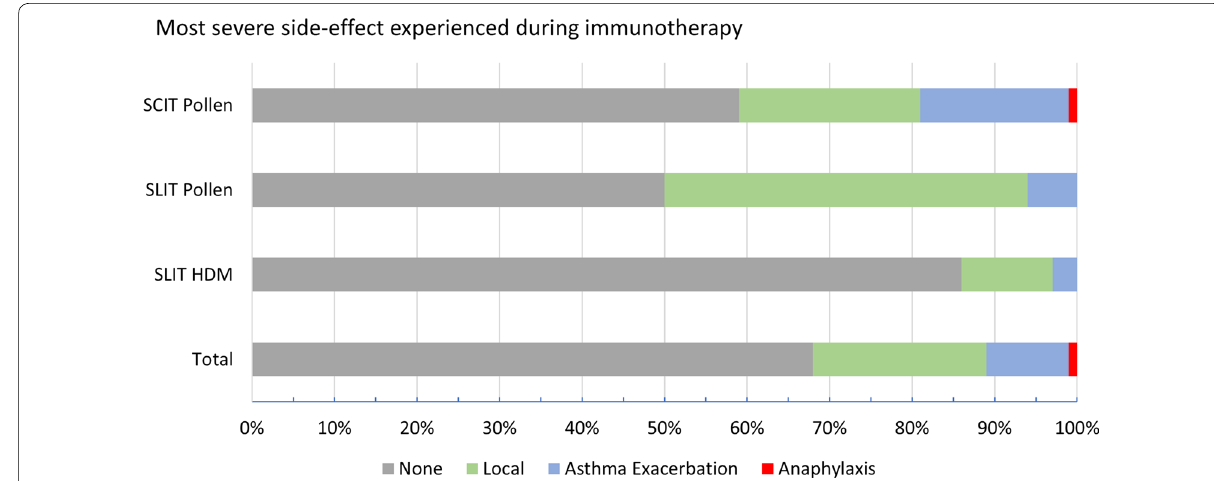
Fig. 3 Adverse events experienced by patients in the total cohort and AIT